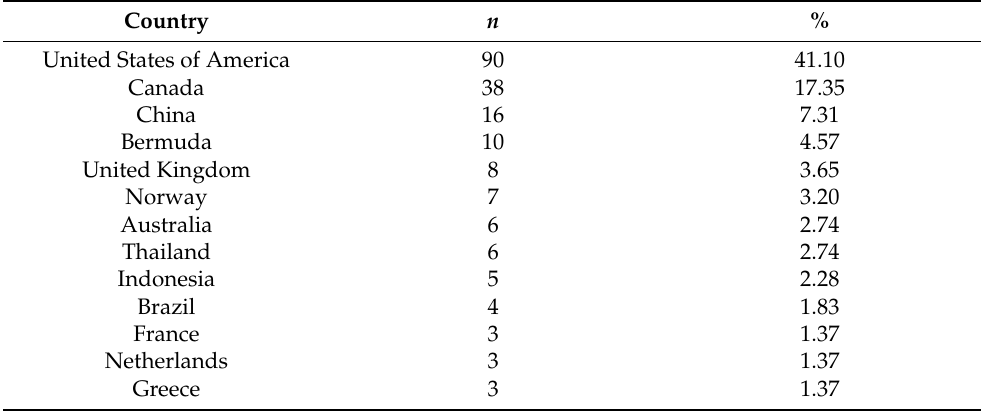
Table 1. The number of analyzed firms by